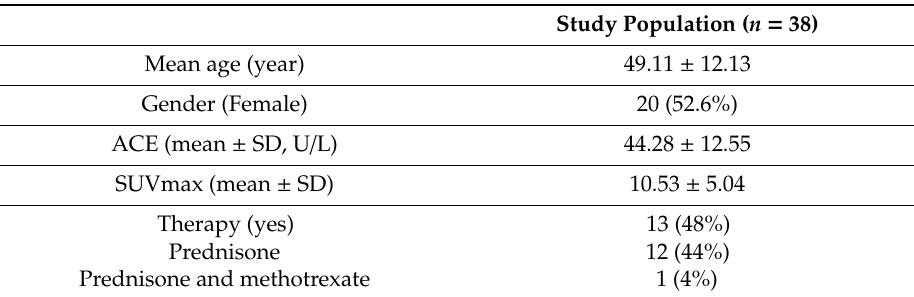
Table 1. Characteristics of study